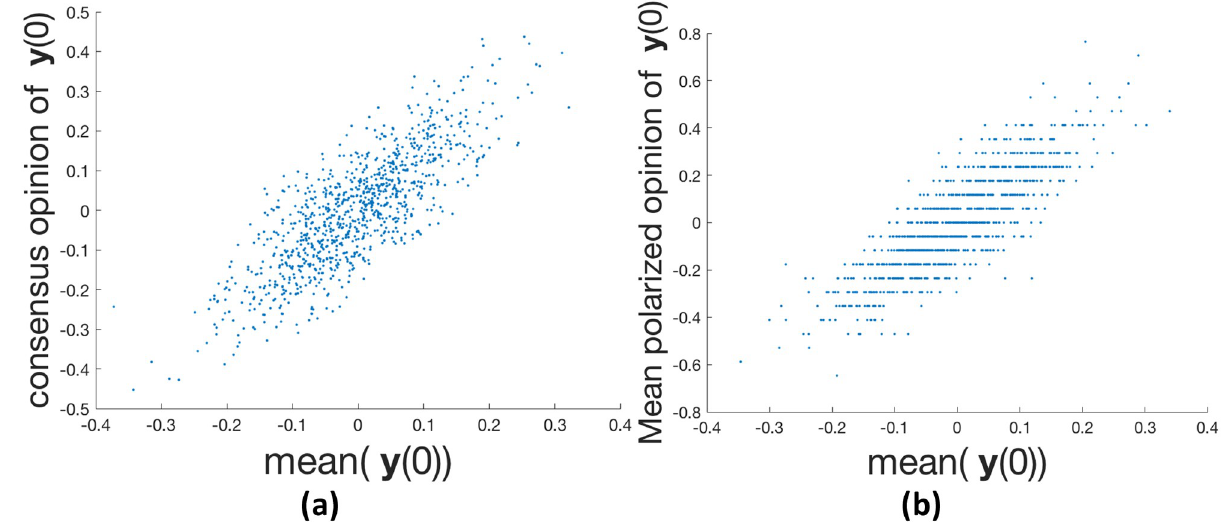
Fig 5. For 1,000 random y(0) on Karate network. (a) consensus opinion when β = 1; (b) mean polarized opinion when β = 10.